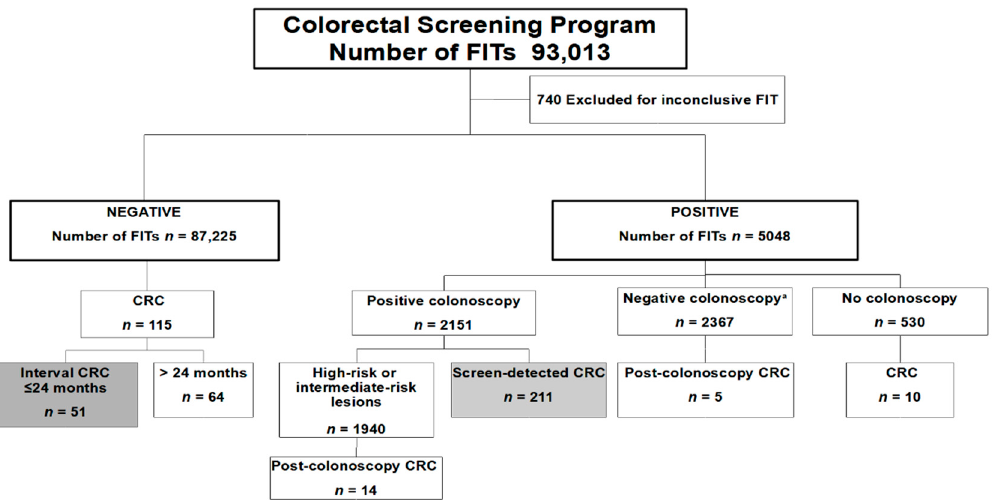
Figure 1. Flow diagram of the participants included in this analysis. CRC: colorectal cancer; FIT: Fecal immunochemical test. a Negative colonoscopy was defined as having low-risk lesions or no preneoplastic lesions. Table 1. Baseline characteristics of participants according to the FIT result.